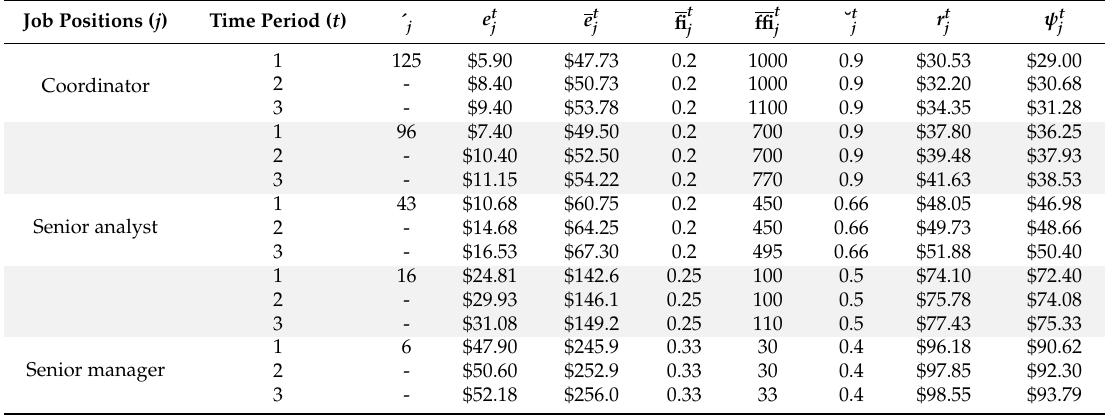
Table 1. The required parameters associated with job positions in three time periods.